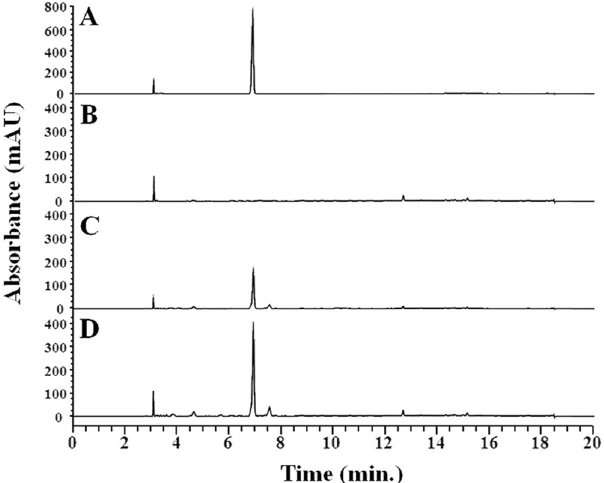
Figure 2. Production of tyrosol using E. coli harboring AAS. ( A ) standard tyrosol; ( B ) AAS from Arabidopsis thaliana ; ( C ) AAS from Petunia hybrid ; ( D ) AAS from Petroselinum crispum